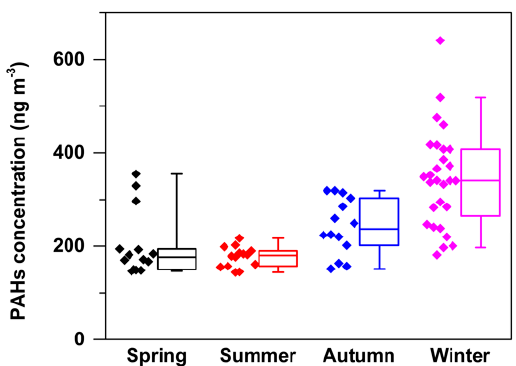
Figure 3. Seasonal distribution of PAHs concentrations. The box plots show median values (the band inside the box), 25th and 75th percentiles (lower and upper box bounds, respectively), and 5th and 95th percentiles (lower and upper whiskers, respectively).